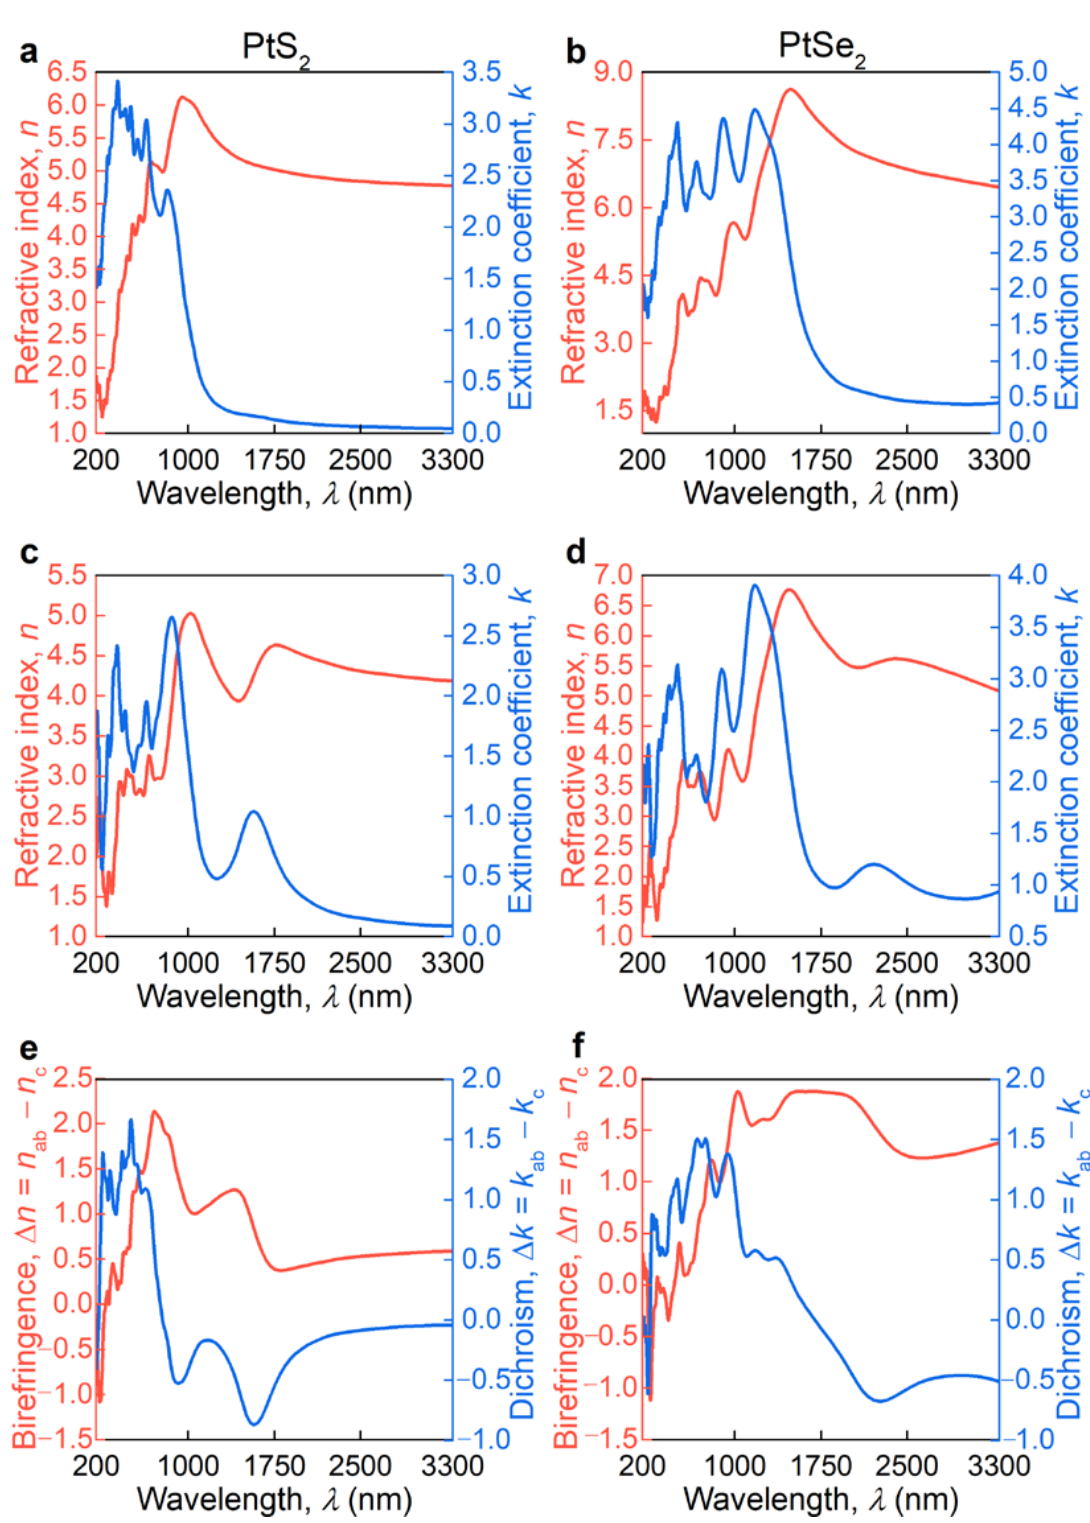
Figure A4. First-principle calculations of PtS 2 and PtSe 2 optical constants. ( a , b ) In-plane optical constants and ( c , d ) out-of-plane optical constants. ( e , f ) Out-of-plane anisotropy. Table A1. Tabulated optical constants for PtS 2 and PtSe 2 films from Figure 3a,b.